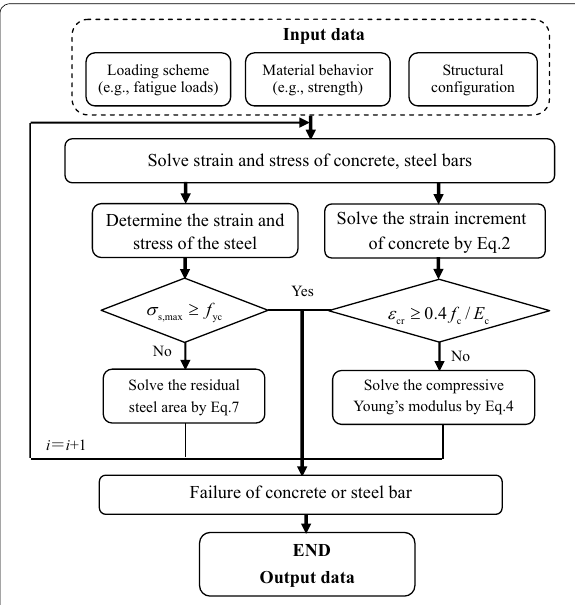
Fig. 8 Fatigue analysis flowchart for the corroded beam. Table 2 Summary of the specimens and loading conditions (Yi et al. 2010). Specimen